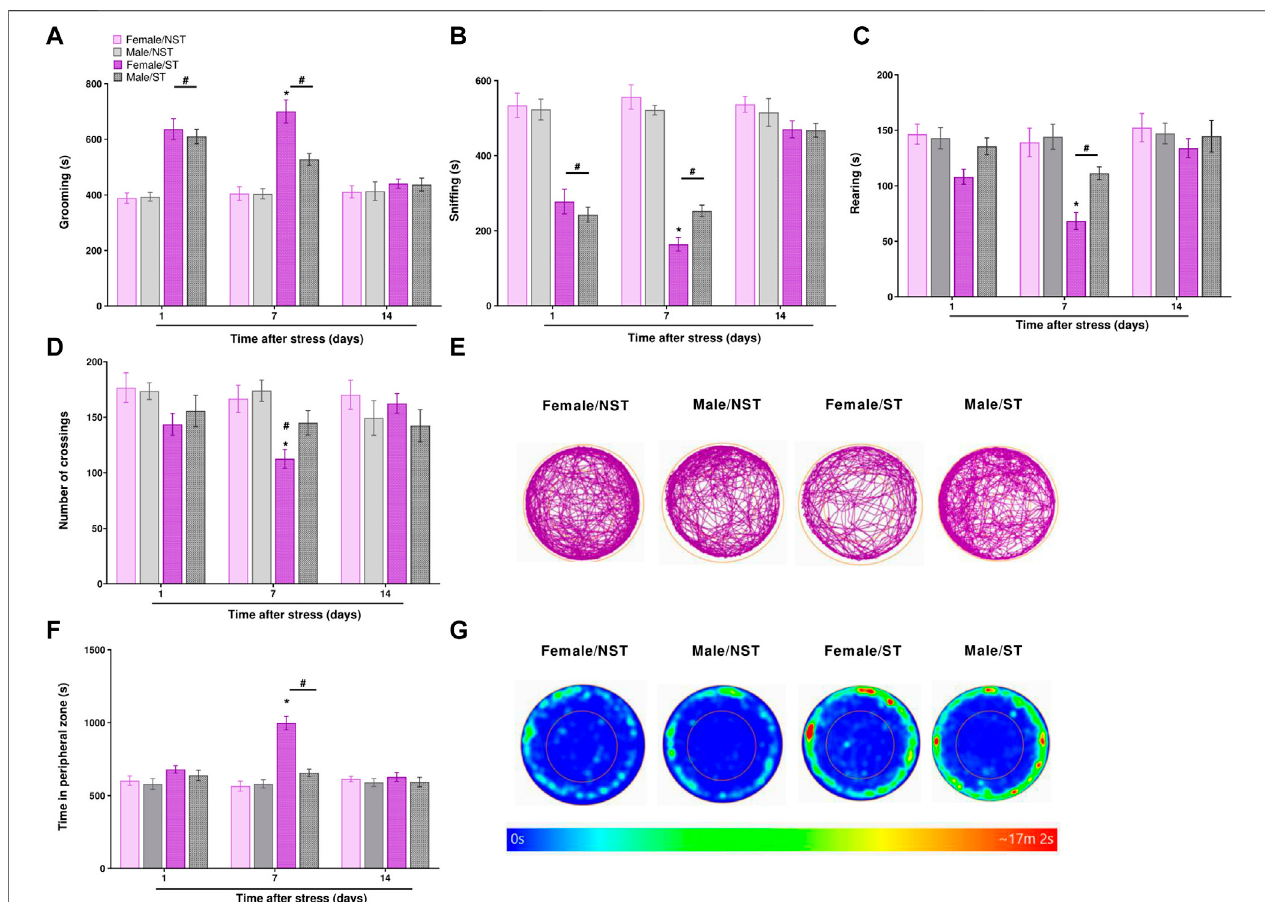
FIGURE3| Anxiety-likesymptomsinductionanddecrease exploratoryactivity afterunpredictable soundstressinduction.Timespent (A) grooming (B) snif fi ng (C) rearing (D) thenumberofcrossings (E) representativeimageofcrossingsrepresentedbytrackplot (F) timeintheperipheralzonewereobservedintheopen fi eldteston days 1, 7, and 14 post-stress (ST group) or in non-stressedgroup (NST). (G) Representative image of time in the peripheral zone represented by heat map. Data are expressed as mean ± S.E.M. (n = 8). * p < 0.05, when compared between the sexes within the ST group. # p < 0.05 when compared to the NST group. [Repeated measures two-way ANOVA followed by Bonferroni ’ s p ’ ost hoc